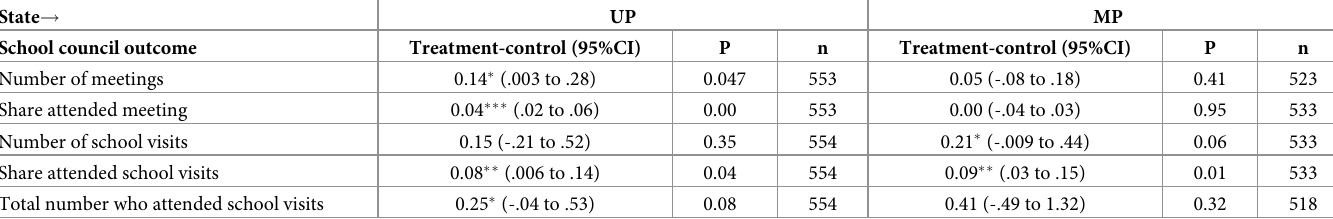
Value represents coefficient on treatment variable. 95% confidence interval in parentheses.